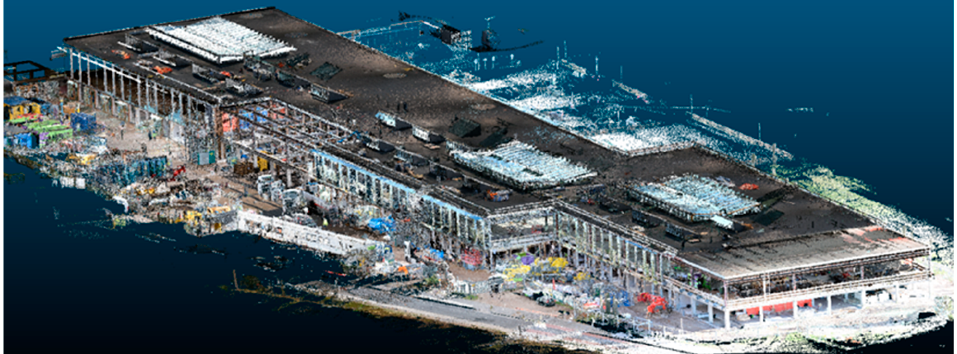
Figure 5. The general point cloud of the new ITC building. Source: author.